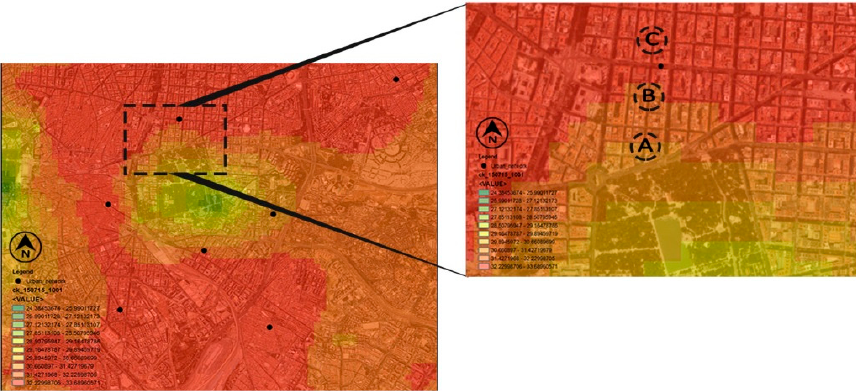
Figure 1. Madrid’s urban heat island (UHI) map on 26 July 2015 [77,79] and the selected northern region of the Retiro Park. Intersection A is in the yellow zone, intersection B is in the orange zone and intersection C is in the red zone, close to one of the UHIs of Madrid. Energies 2019 , 12 , x FOR PEER REVIEW